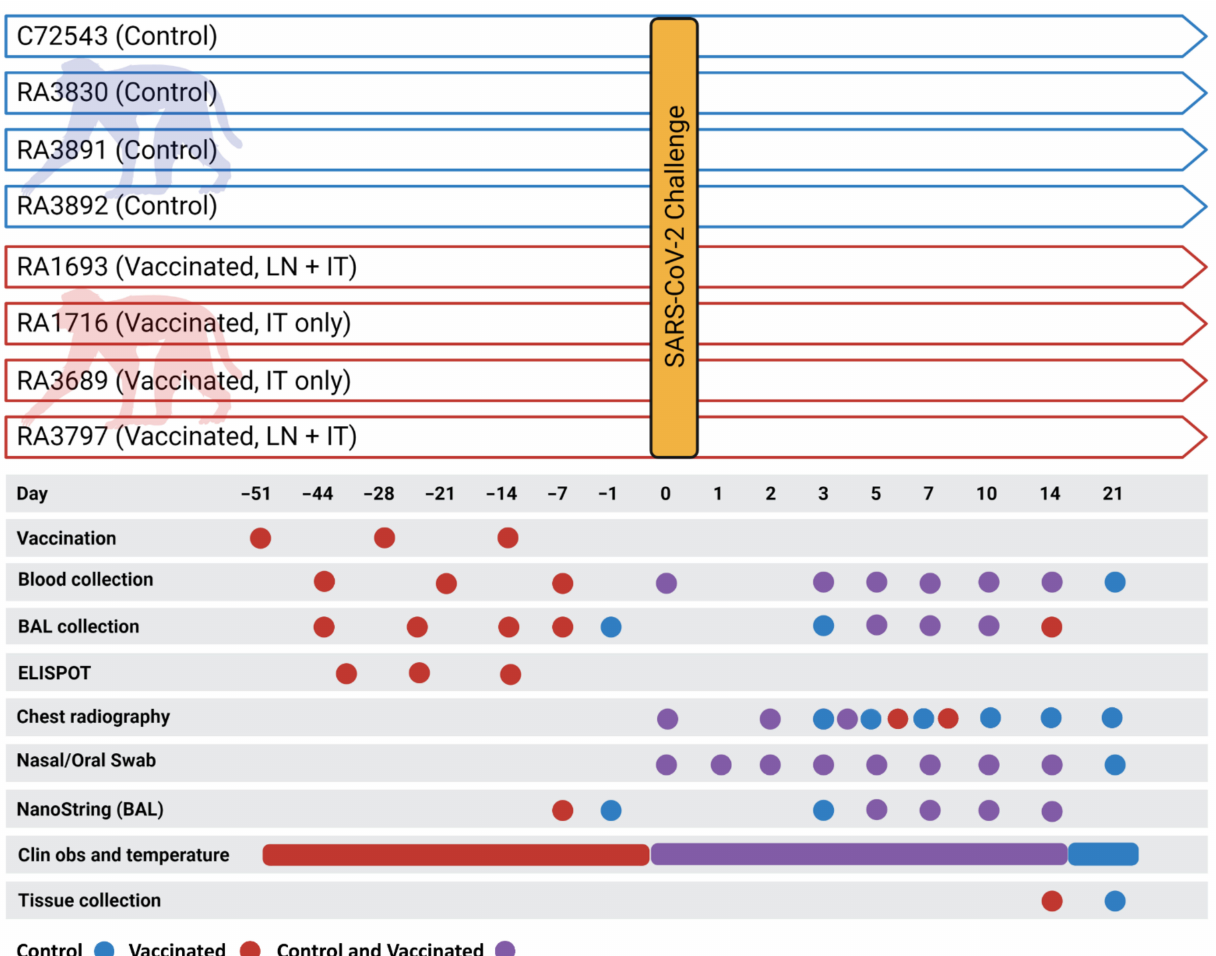
Figure 1. Legend. Schematic of the experimental protocol. Unvaccinated (control) macaques are represented by blue coloring. Vaccinated macaques are represented by red coloring. Overlapping tasks are represented by purple coloring. Graphic created with